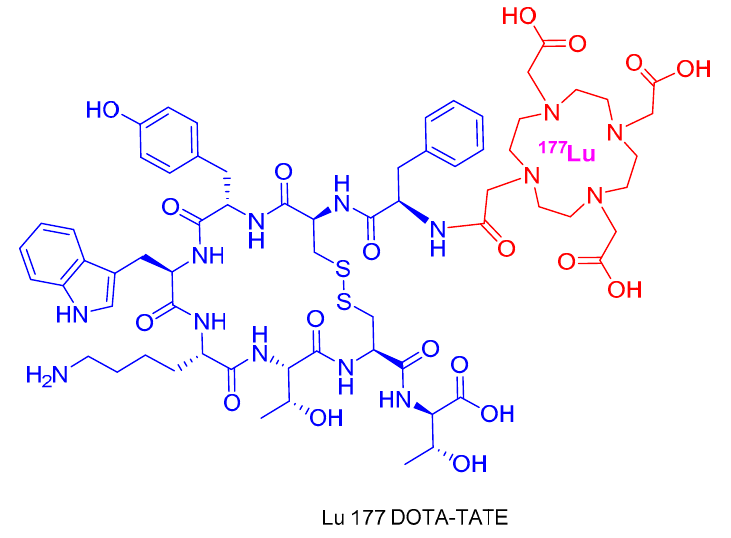
Figure 3. Structure of Lu 177 DOTA-TATE.